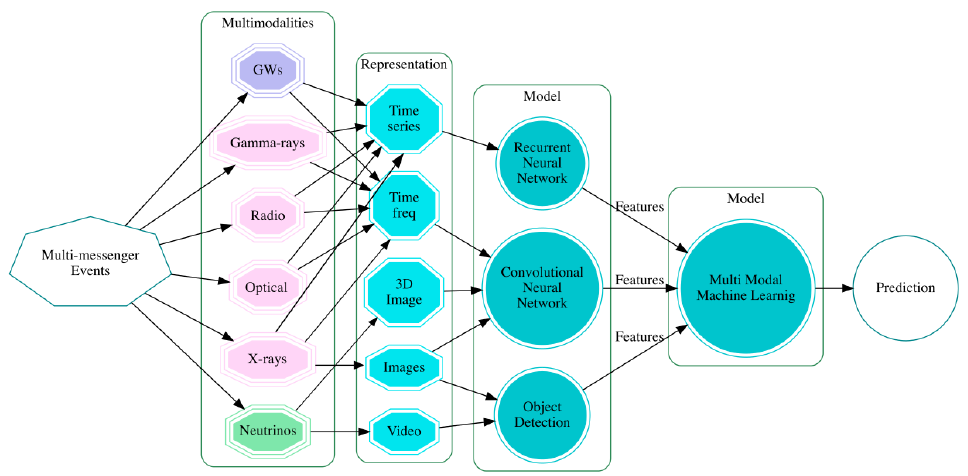
Figure 2. An astrophysical phenomenon such as core-collapse supernova (CCSN) or NS-NS or BH-NS coalescence (multi-messenger events) can manifest itself through different signal types, such as gravitational waves, gamma-rays, X-rays, optical and radio emission, and neutrinos. The different modalities have their own representations in different domains. By using DL and ML models, we can use the extracted features to perform model prediction at an early stage. At a later stage, we can use the predicted features by combining them in the global MML